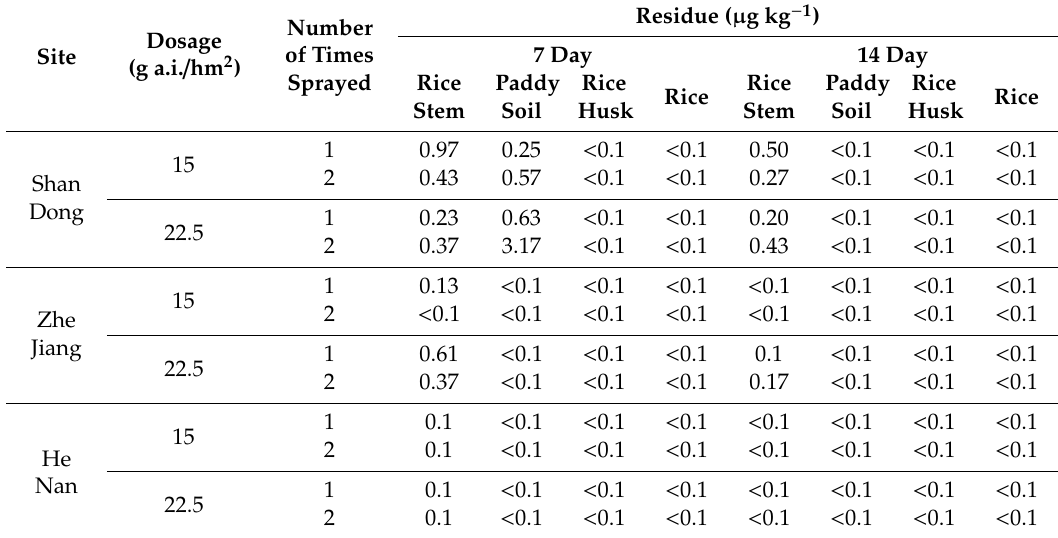
Table 4. The final residue of emamectin benzoate in plants, rice hull, rice, and